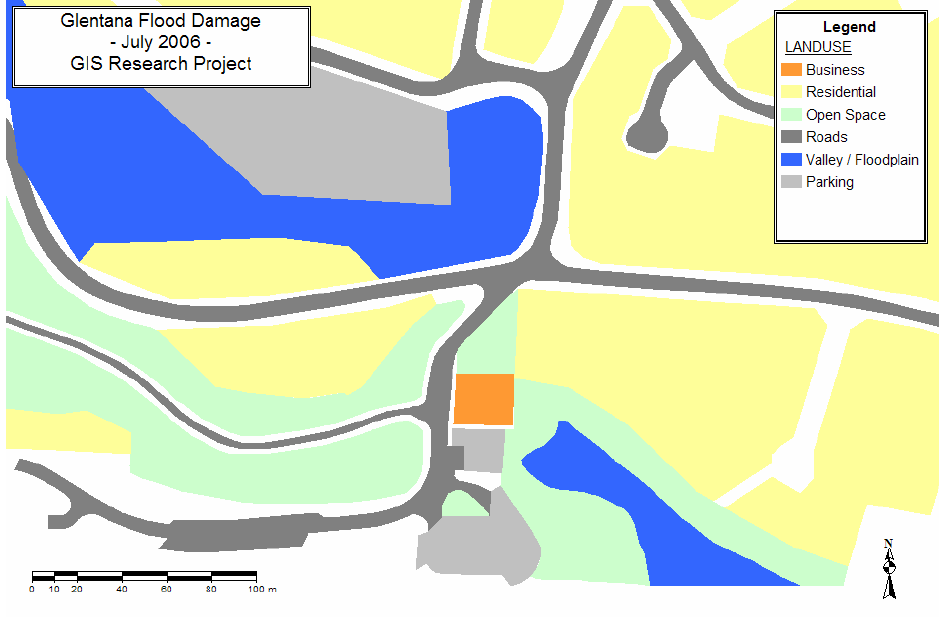
Figure 4: Land use data captured from aerial photography. Source: Google Earth ™